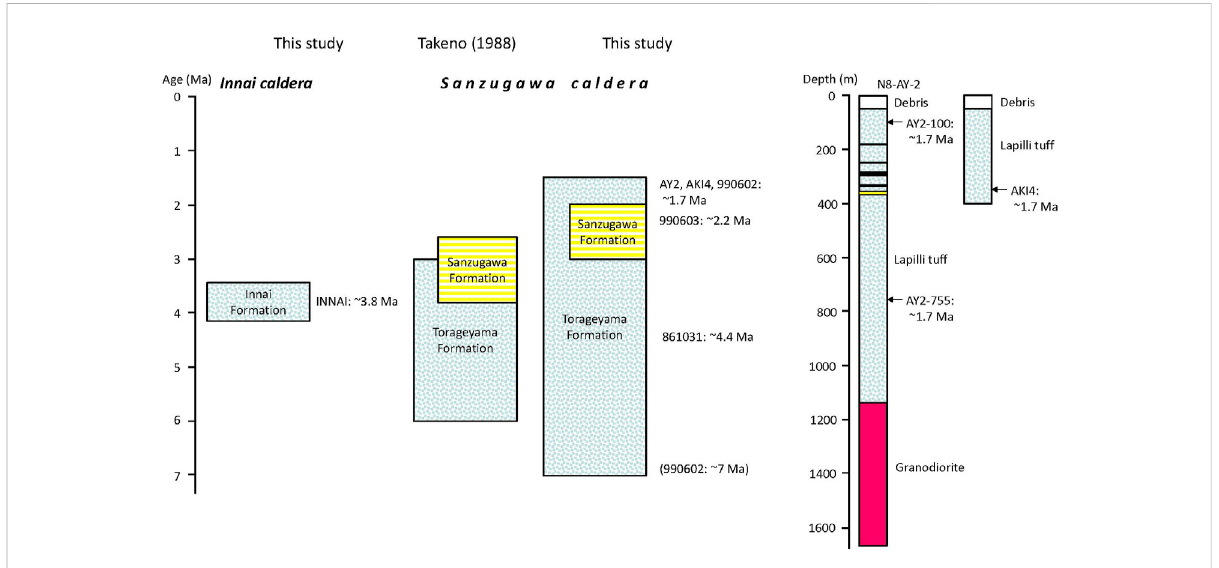
FIGURE 3 Lithostratigraphy related to caldera-forming eruptions in the Sanzugawa and Innai calderas. Sample names and zircon U-Pb ages are shown at their corresponding positions. The age of ~7 Ma of sample 990602 corresponds to the old component age. Sampling elevations are shown in Supplementary Table